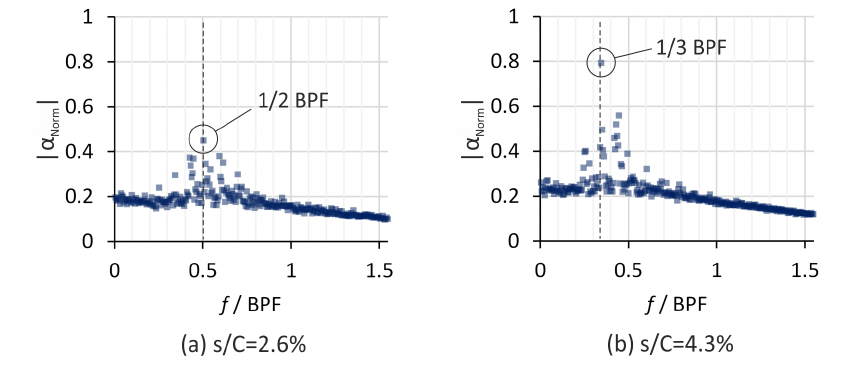
Figure 10. DMD spectra ( s / C = 2.6% at Φ = 0.50; s / C = 4.3% at Φ =